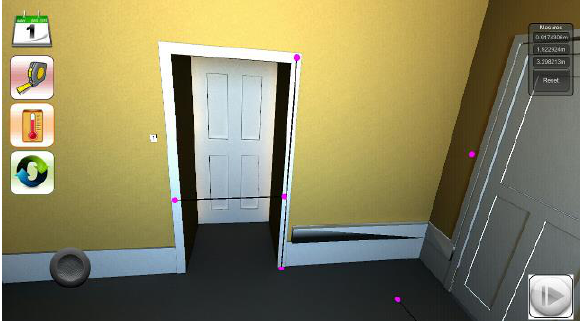
Figure 8. Taking